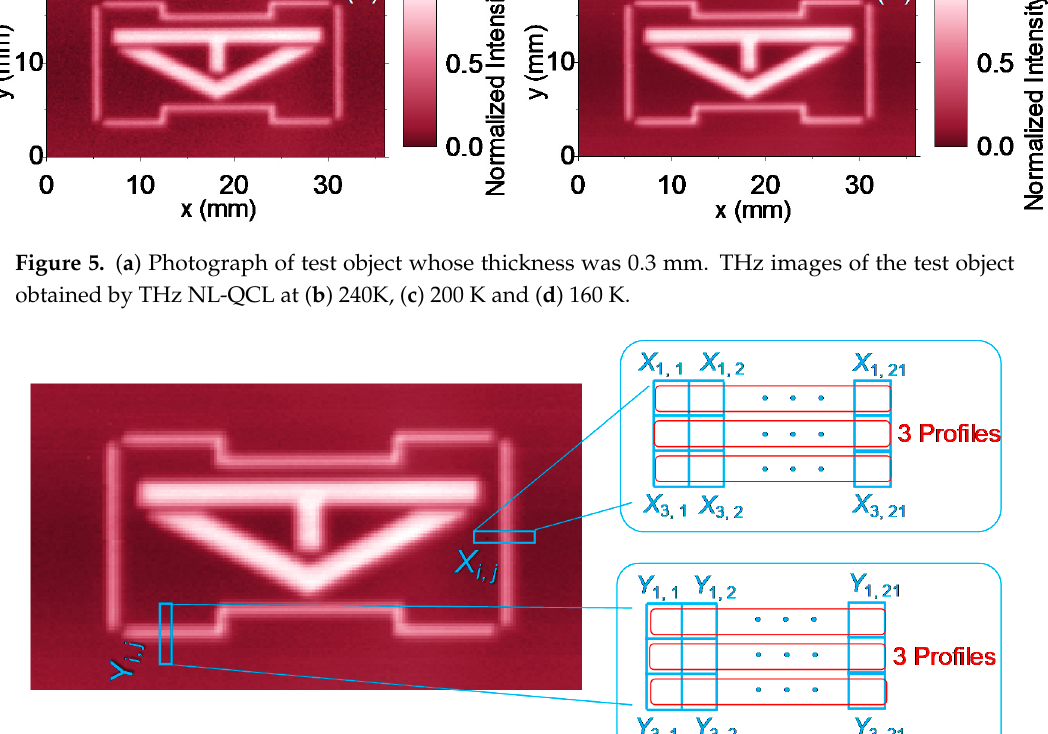
Figure 7. Line profiles of normalized THz intensity along horizontal direction at: ( a ) 240 K, ( b ) 200 K and ( c ) 160 K. Line profiles of normalized THz intensity along vertical direction at: ( d ) 240 K, ( e ) 200 K and ( f ) 160 K. Insets show profiles of non-normalized intensity. 2